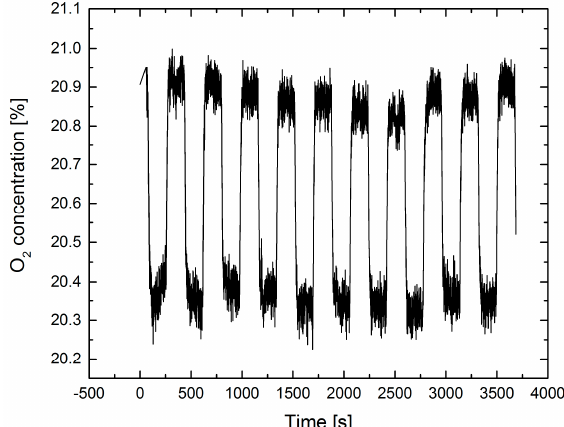
Figure 7. Standoff O 2 measurement using a diffuse reflecting gas cell instead of the leak plate of Figure 1b. The total optical path length (laser-diffuse reflecting backplate-detector) was 114 cm. The optical path length in the cell was 30 mm. The gas in the cell was periodically changed from lab air to 100% N 2 .